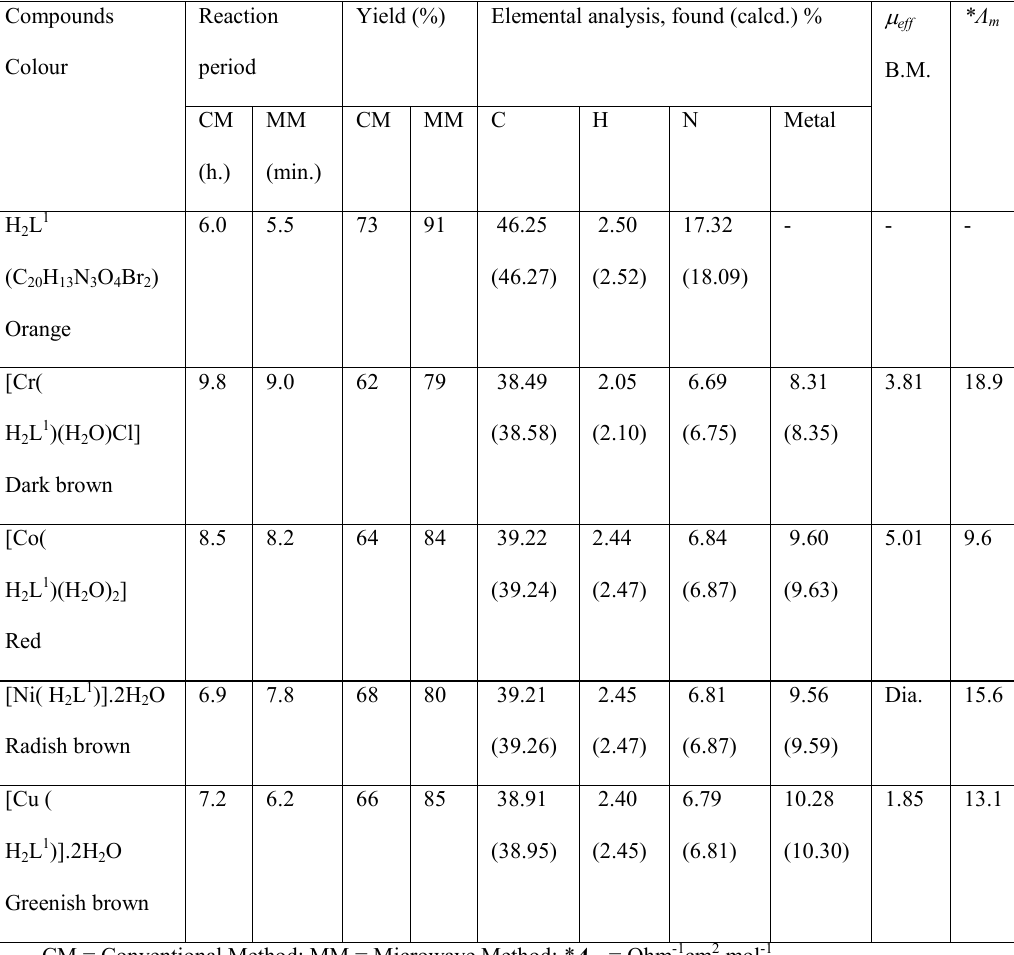
Table 1. The comparative results of conventional and microwave methods, analytical and physical data of the